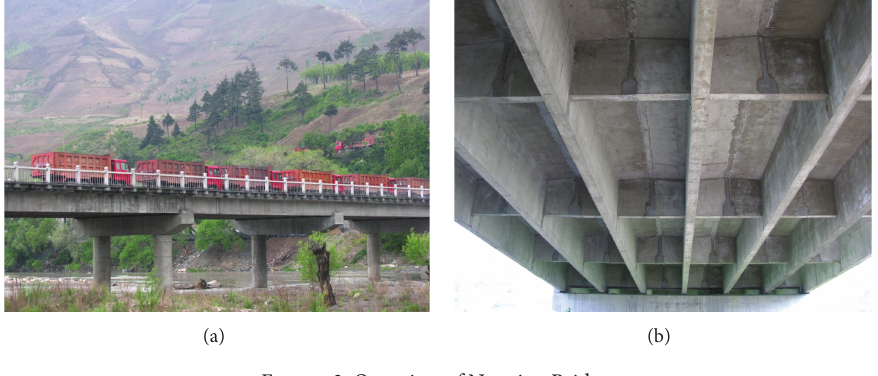
Figure 3: Overview of Nanping Bridge.